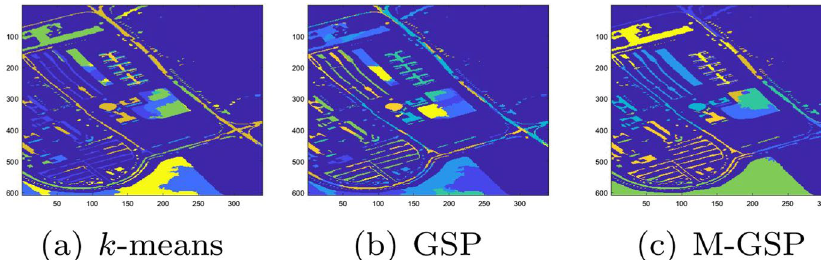
Fig. 11 Segmented results of Pavia